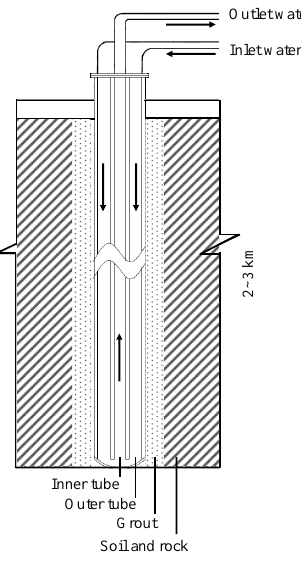
Figure 2. A diagram of the deep borehole heat exchangers